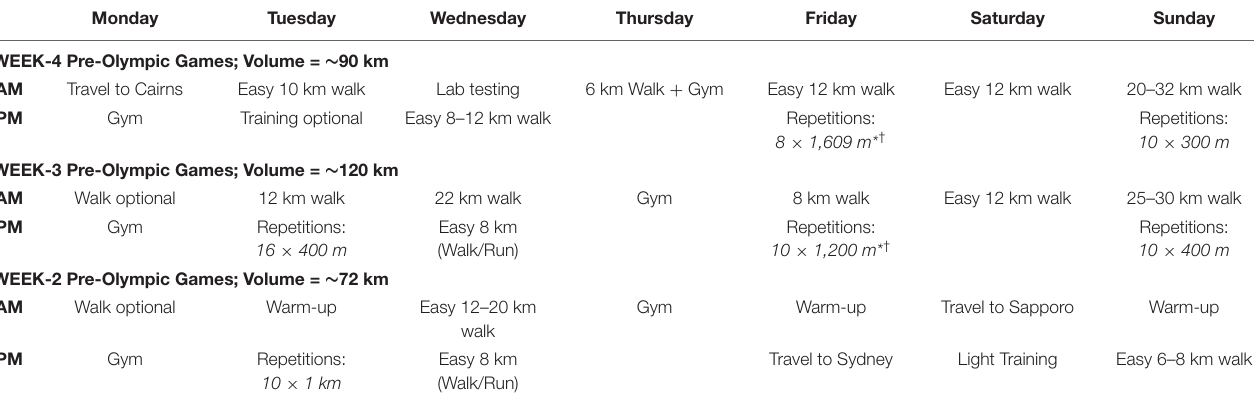
TABLE 3 | Weekly training plan overview for race walking athletes ( n = 6; three males, three females) during the team holding